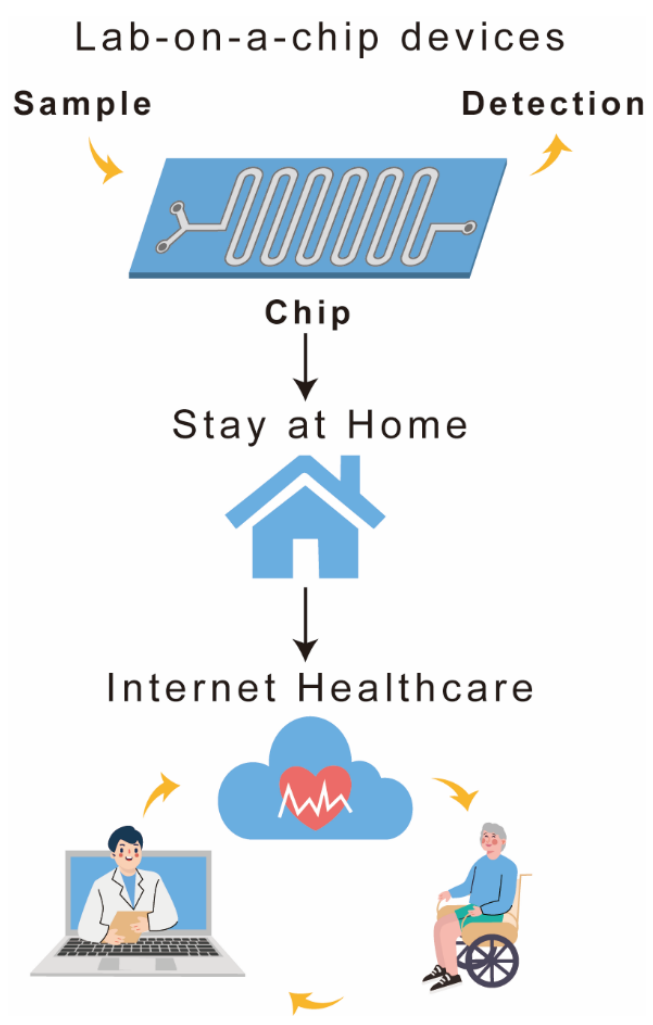
Figure 12. Schematic representation of the IoMT system.